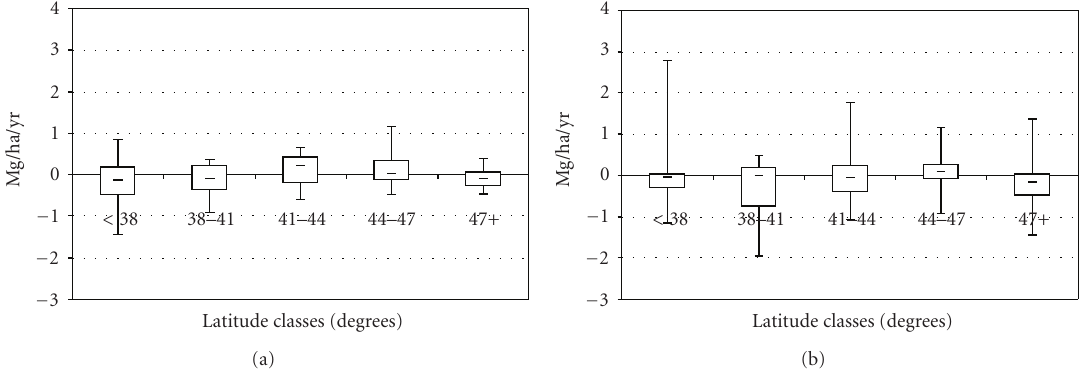
Figure 2: Box plots of carbon flux (Mg/ha/yr) by 3 degree latitude classes for (a) fine woody debris and (b) coarse woody debris across the north central United States, 2002 to 2007.